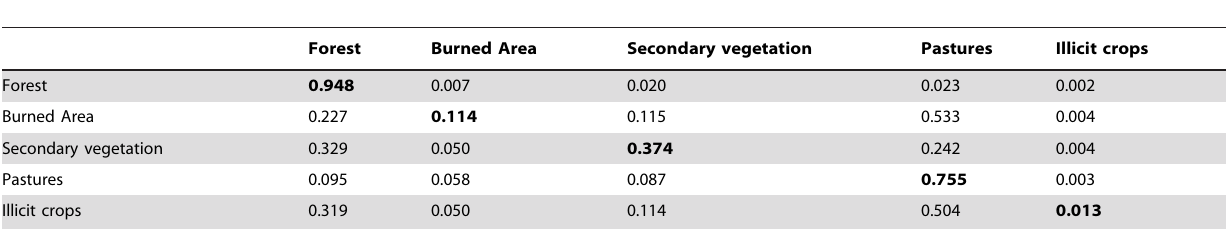
Table 2. Land use transition probability matrix (P) for the entire study area over an 8-year time step.